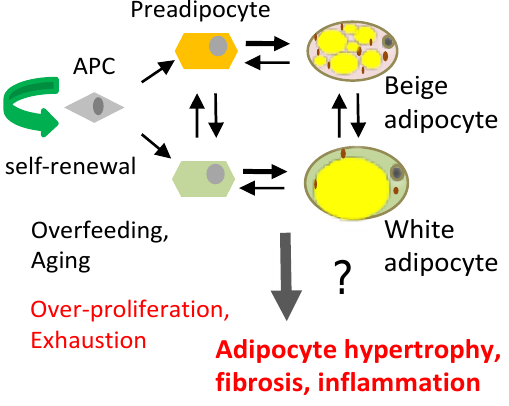
Figure 5. APCs di ff erentiate into distinct lineages of preadipocytes: Pdgfr β - predisposed to beige adipogenesis and Pdgfr β + predisposed to white adipogenesis. The depletion of these lineages in di ff erent depots may have distinct e ff ects on adipocyte number, size, and AT dysfunction, leading to Figure 5. APCs differentiate into distinct lineages of preadipocytes: Pdgfrβ- predisposed to beige fibrosis and adipogenesis and Pdgfrβ+ predisposed to white adipogenesis. The depletion of these lineages in different depots may have distinct effects on adipocyte number, size, and AT dysfunction, leading to fibrosis and inflammation.